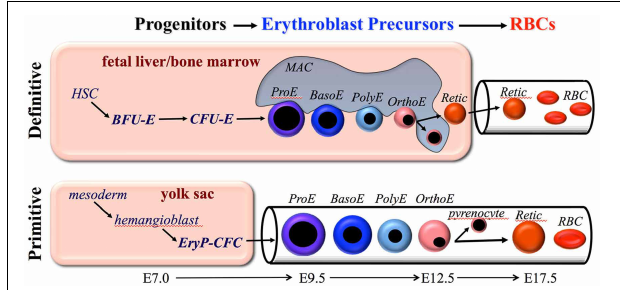
FIGURE 1 | Overview of primitive and definitive erythropoiesis. Both forms of erythroid cell production are characterized by the progressive movement of cells through three compartments: progenitors, erythroblast precursors, and red blood cells (RBCs). Erythroid progenitors (BFU-E, CFU-E, and EryP-CFC) are defined by their capacity to form colonies of maturing erythroid cells in vitro . Erythroid precursors are defined morphologically as proerythroblasts (ProE), basophilic erythroblasts (Baso), polychromatophilic erythroblasts (PolyE), and orthochromatic erythroblasts (OrthoE). OrthoE enucleate to form a pyrenocyte, that contains the condensed nucleus, and a reticulocyte (Retic), that goes on to mature into a RBC. Definitive erythropoiesis in the adult organism is derived from hematopoietic stem cells (HSC), while primitive erythropoiesis occurs just once from mesoderm cells in the early